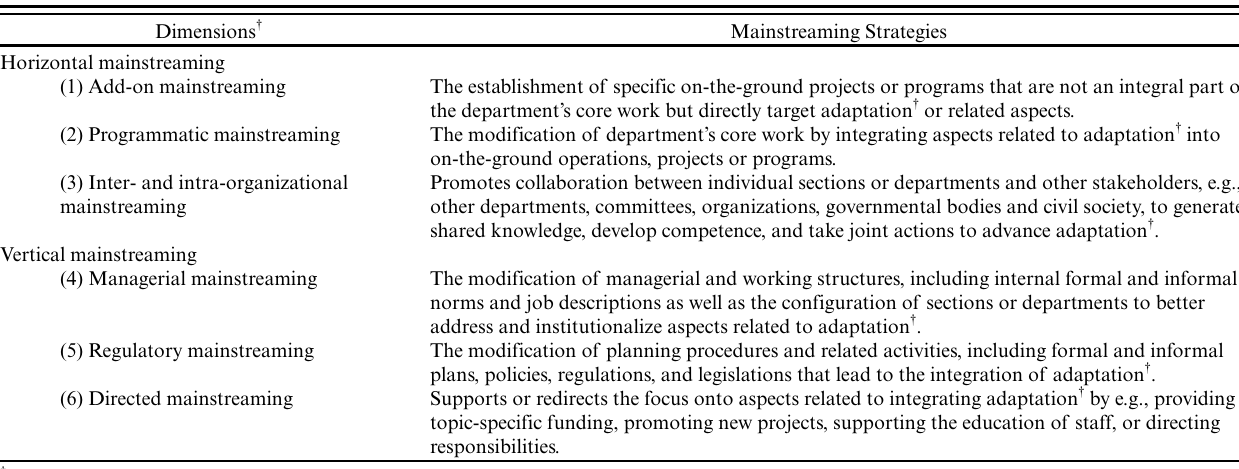
Table 1 . Mainstreaming